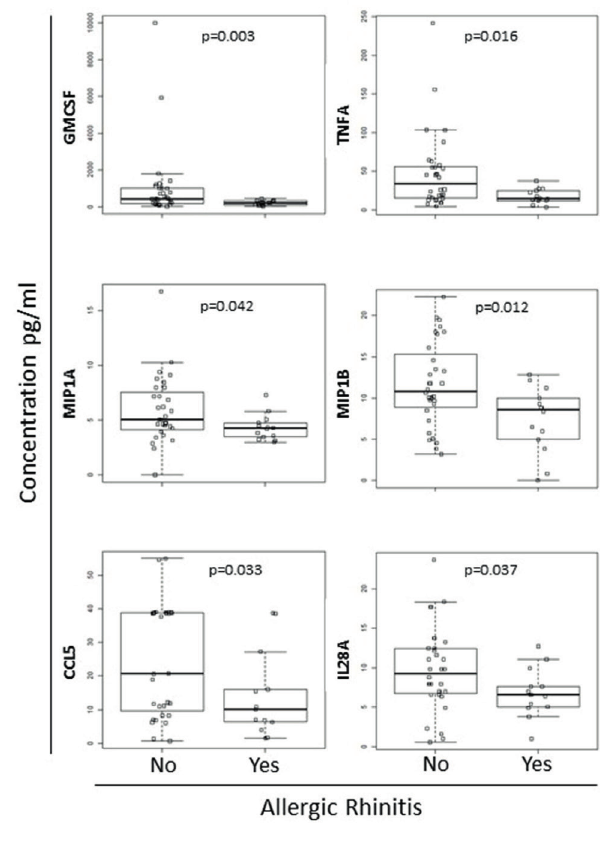
Figure 1. A set of 6 side-by-side boxplots combined with strip-chart visualizations that illustrate the statistically significantly dissimilar pro- tein expression levels of control and AR subjects, accompanied with the p-values of the